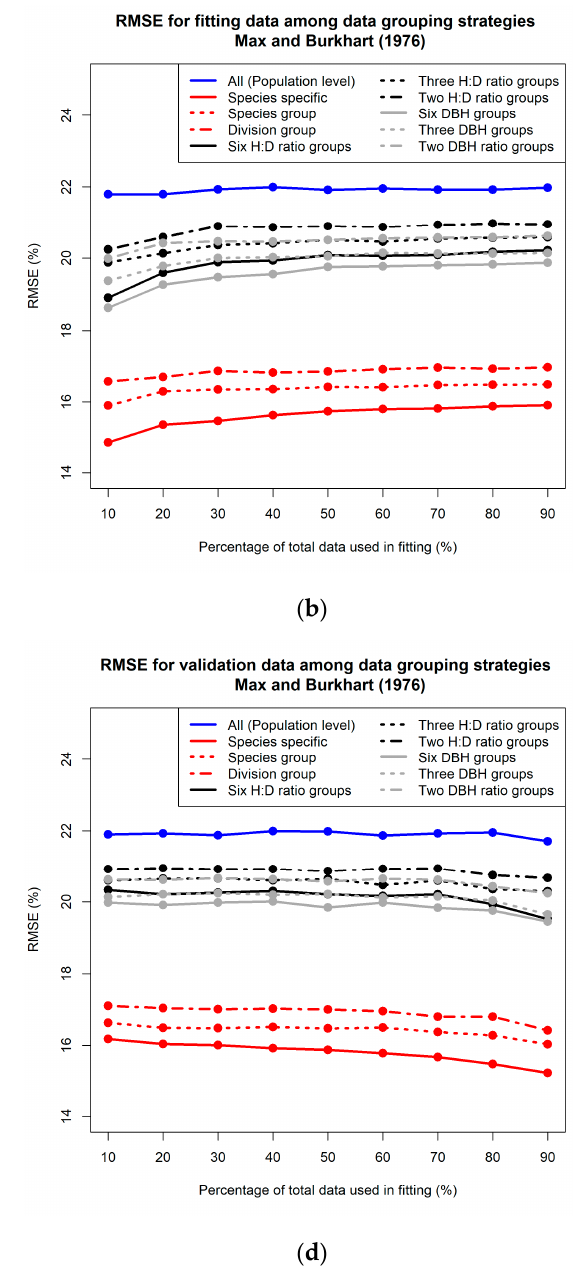
Figure 3. Summary of percent mean bias (MB) and percent root mean square error (RMSE) among data grouping strategies by Max and Burkhart (1976) model. Fitting/validation datasets were split as 10/90, 20/80, 30/70, 40/60, 50/50, 60/40, 70/30, 80/20 and 90/10 (%), respectively. ( a ) MB, fitting, ( b ) RMSE, fitting, ( c ) MB, validation, ( d ) RMSE, validation. Table 2. Summary of percent mean bias (MB) and percent root mean square error (RMSE) for vali- dation among six species by Kozak (2004) and Max and Burkhart (1976) models. Fitting/validation datasets were split as 10/90, 50/50 and 90/10 (%), respectively. Mean Bias (%) RMSE (%)